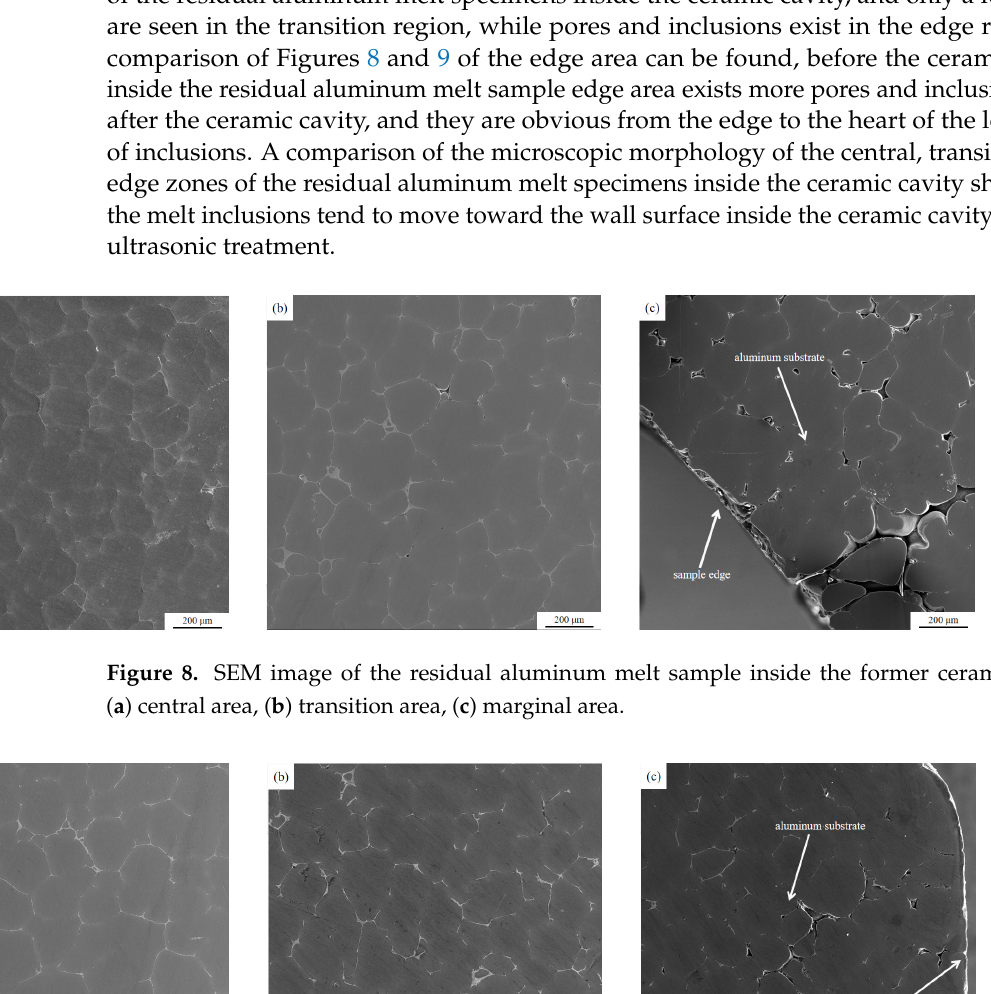
Figure 10. Inclusions contained in residual aluminum melt samples in ceramic cavity: inclusion morphology and EDS spectrum. ( a ) Inclusions 1/( b ) Inclusions 2. As can be seen from Figure 10, the inclusions of the residual melt in the ceramic cavity are accompanied by the porosity, and from the composition analysis of EDS, it can be seen that the inclusions of the residual melt in the ceramic cavity contain significantly more composition elements than the launder melt samples (as shown in Table 2). In the ele- mental composition of inclusions, in addition to the O element, there are also refining agents such as K, Ca, and Cl. This is mainly due to the effect of ultrasonic cavitation nuclei